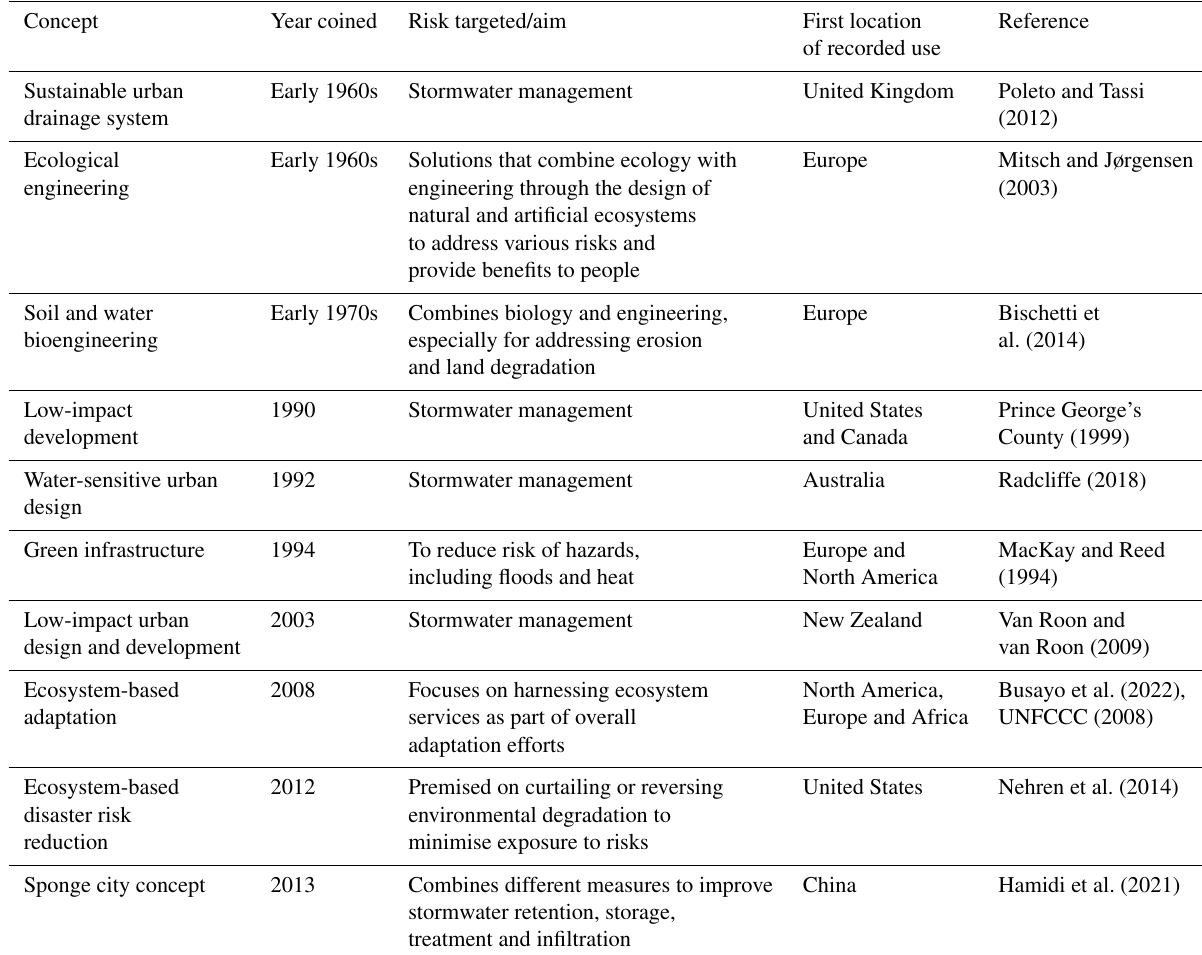
Table 1. Earlier NBS-related concepts that sought to work with